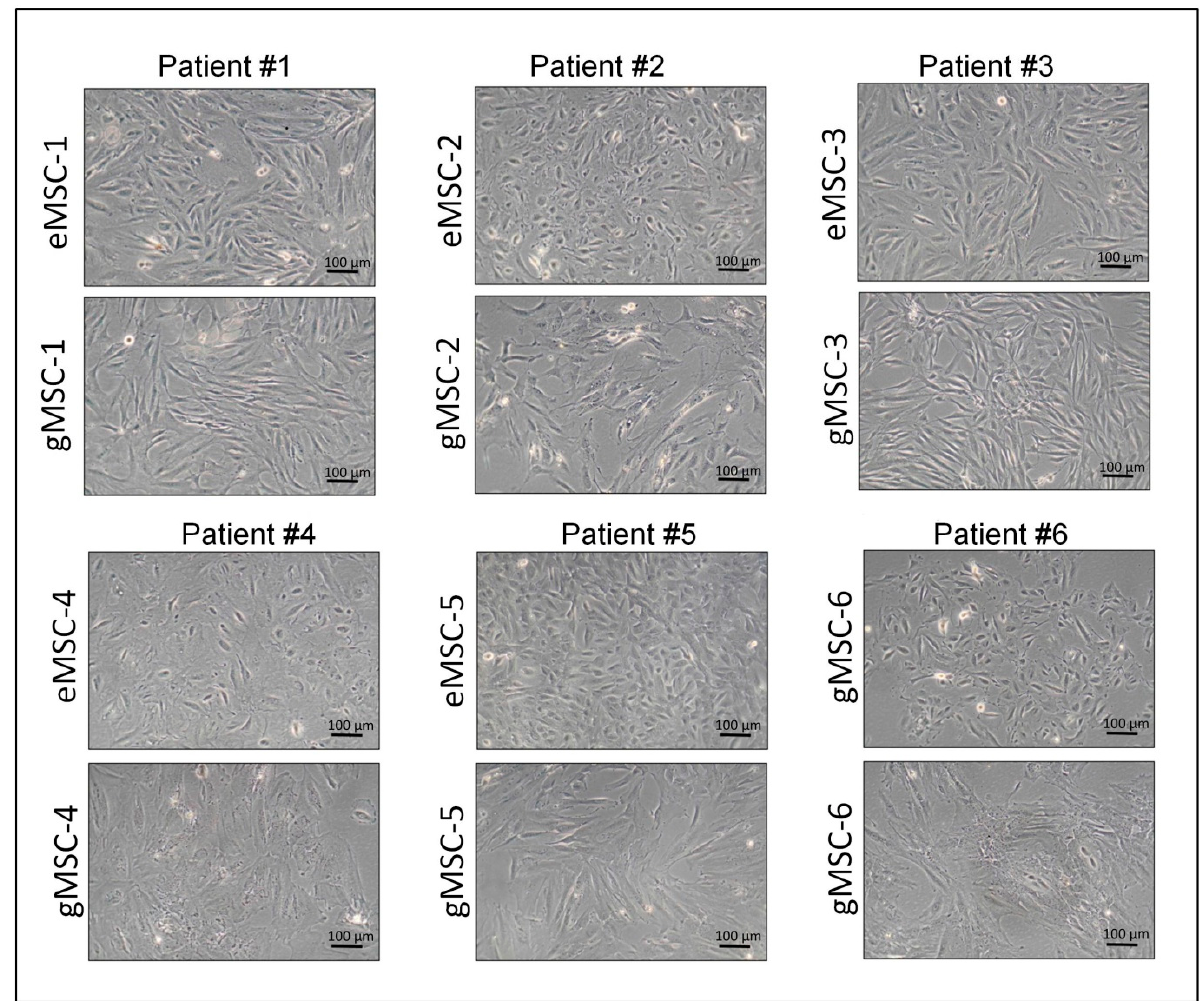
Figure 1. Cell cultures initiated from eutopic endometrium (eMSC) and endometrioid heterotopias (gMSC) of the patients with extragenital endometriosis (passage 3). Phase contrast. Scale bar: 100 microns .